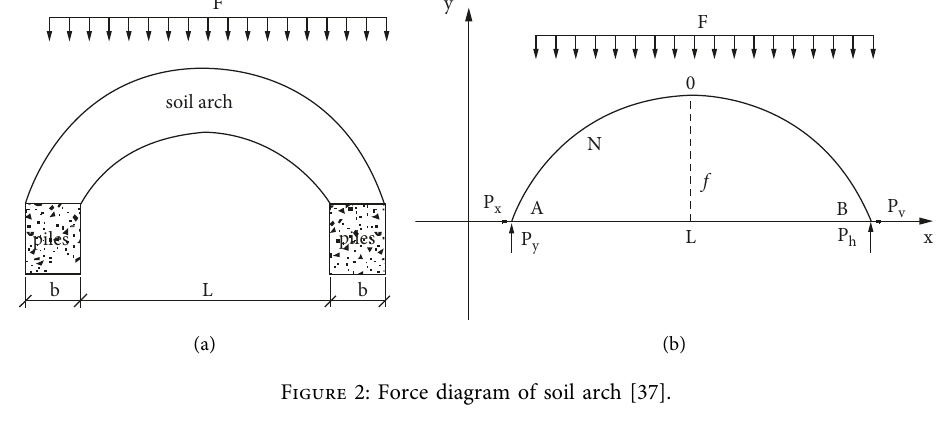
Figure 2: Force diagram of soil arch